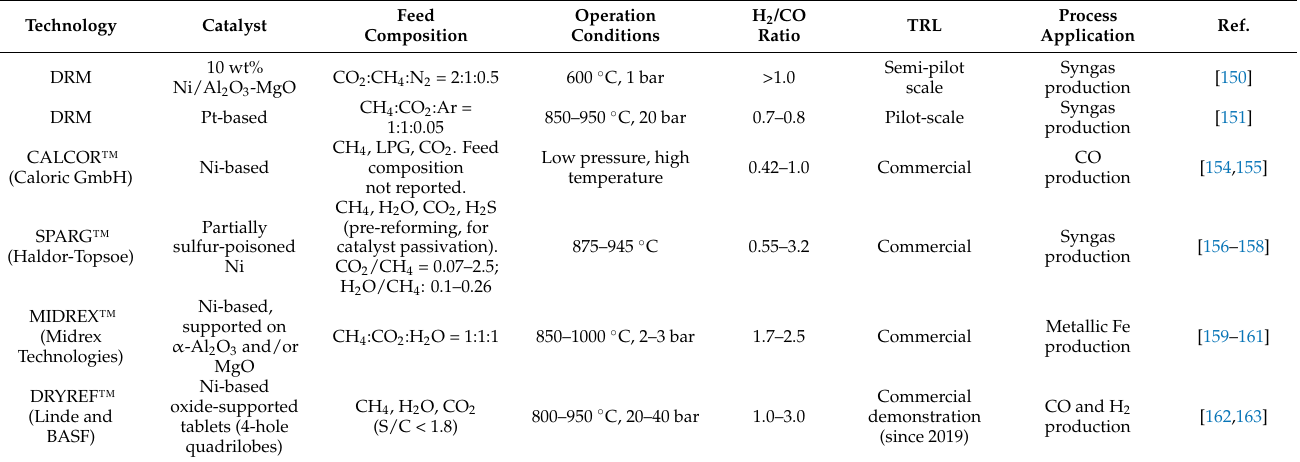
Table 2. Summary of large-scale DRM